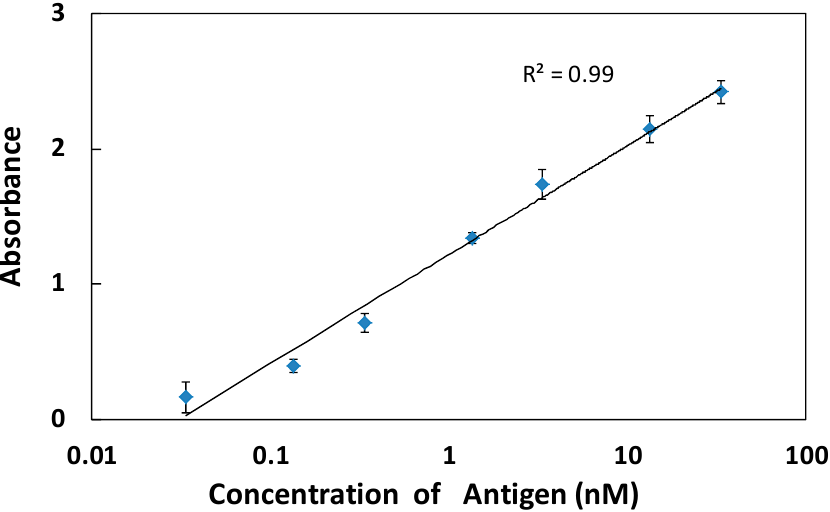
Figure 7. Specific signal as a function of antigen concentration on the (PDDA/PAA) 3 substrate, without OVA adsorption. The primary antibody was covalently immobilized on the substrate at a concentration of 10 µ g/mL ( n = 3).